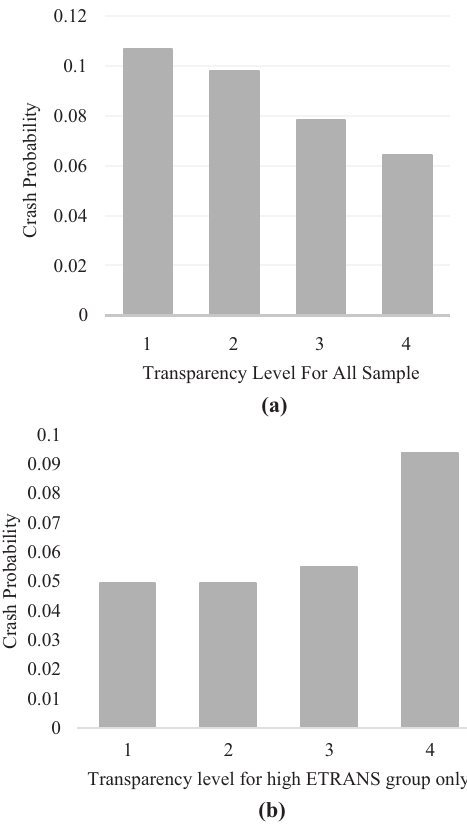
Figure 4. (a) Crash prob. for all ETRANS level (b) Crash prob. for